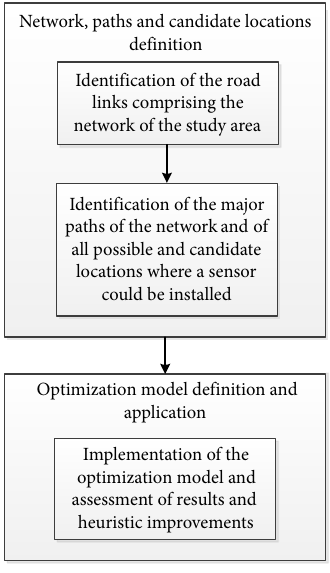
Fig. 1. Methodological flowchart